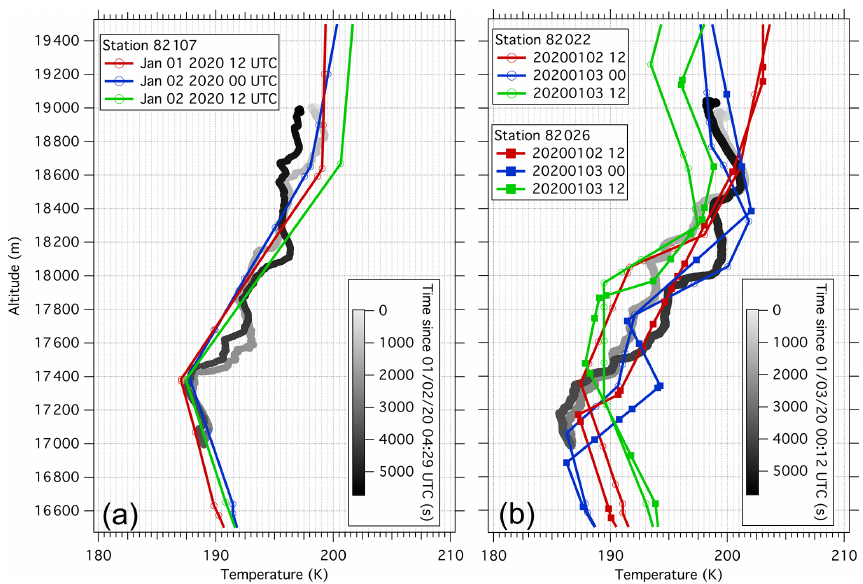
Figure 6. Comparison between RACHuTS temperature profiles and radiosonde soundings as a function of geometric (GPS) altitude. (a) RACHuTS profile collected at 04:50 on 1 January 2020 (1.08, − 68 . 75) and the three closest in time radiosonde soundings from São Gabriel da Cachoeira, Brazil ( − 0 . 12, − 66 . 97, 239km from profile). (b) RACHuTS profile collected at 00:12 on 3 January 2020 (2.10, − 58 . 66) and the three closest in time radiosonde soundings from Boa Vista, Brazil (2.83, − 60 . 70, 240km from profile) and Tirios, Brazil (2.22, − 55 . 95, 302km from profile).